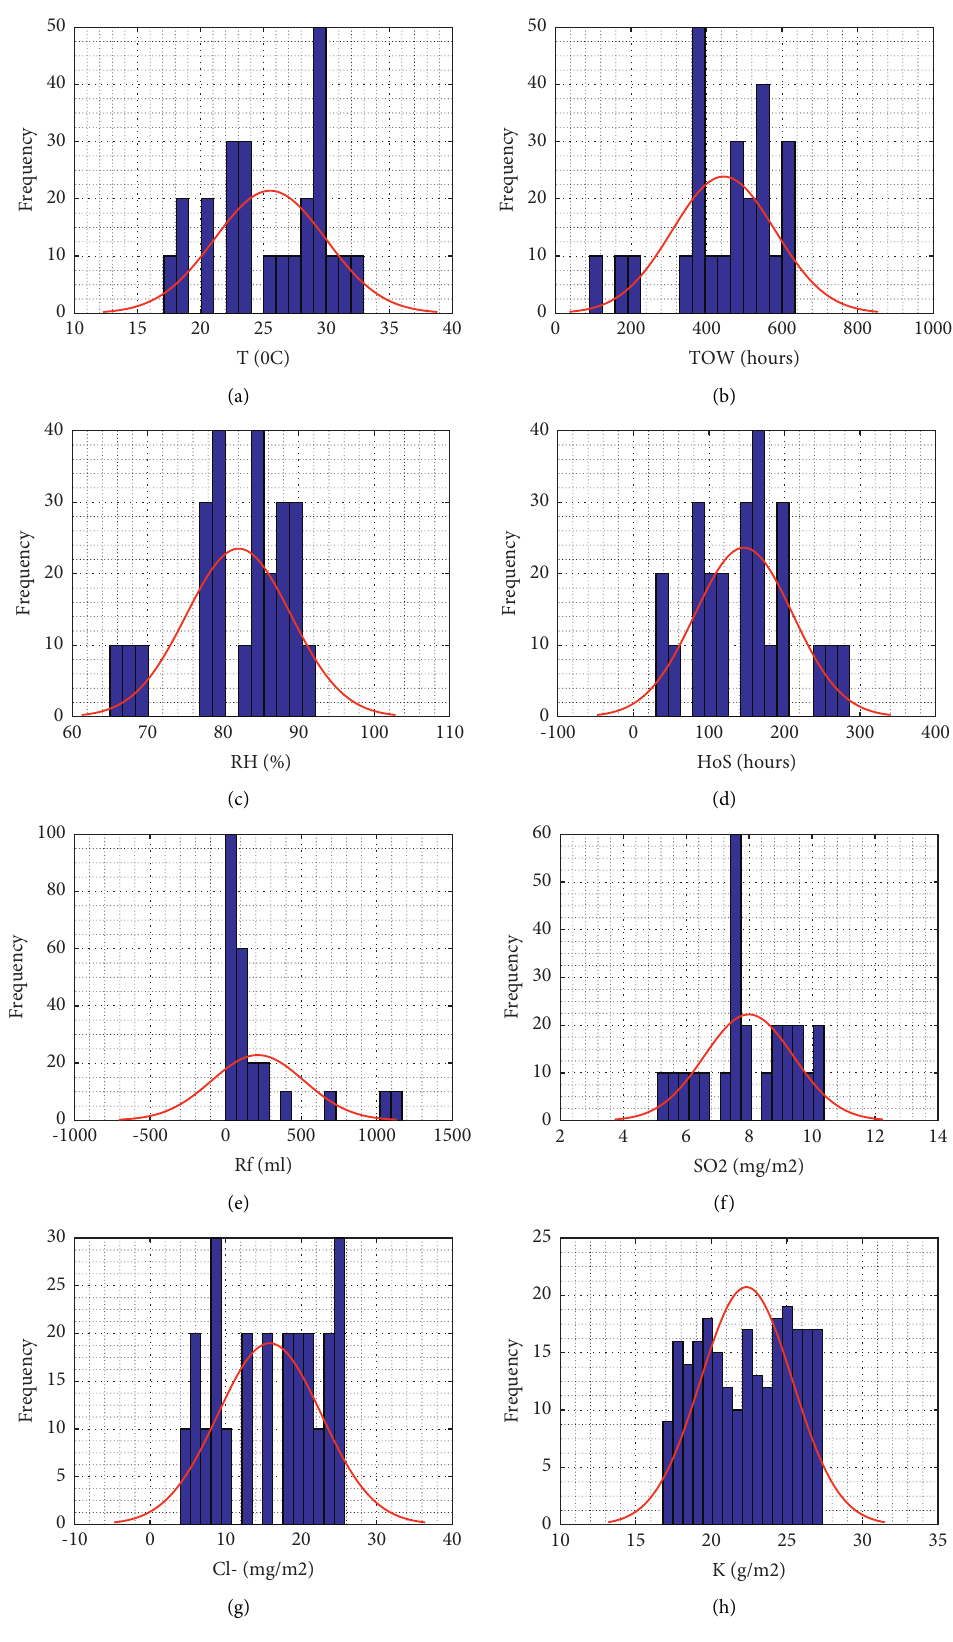
Figure 1: Histograms and normal distribution curves of experimental datasets (noting that the red curves represent the normal distribution of